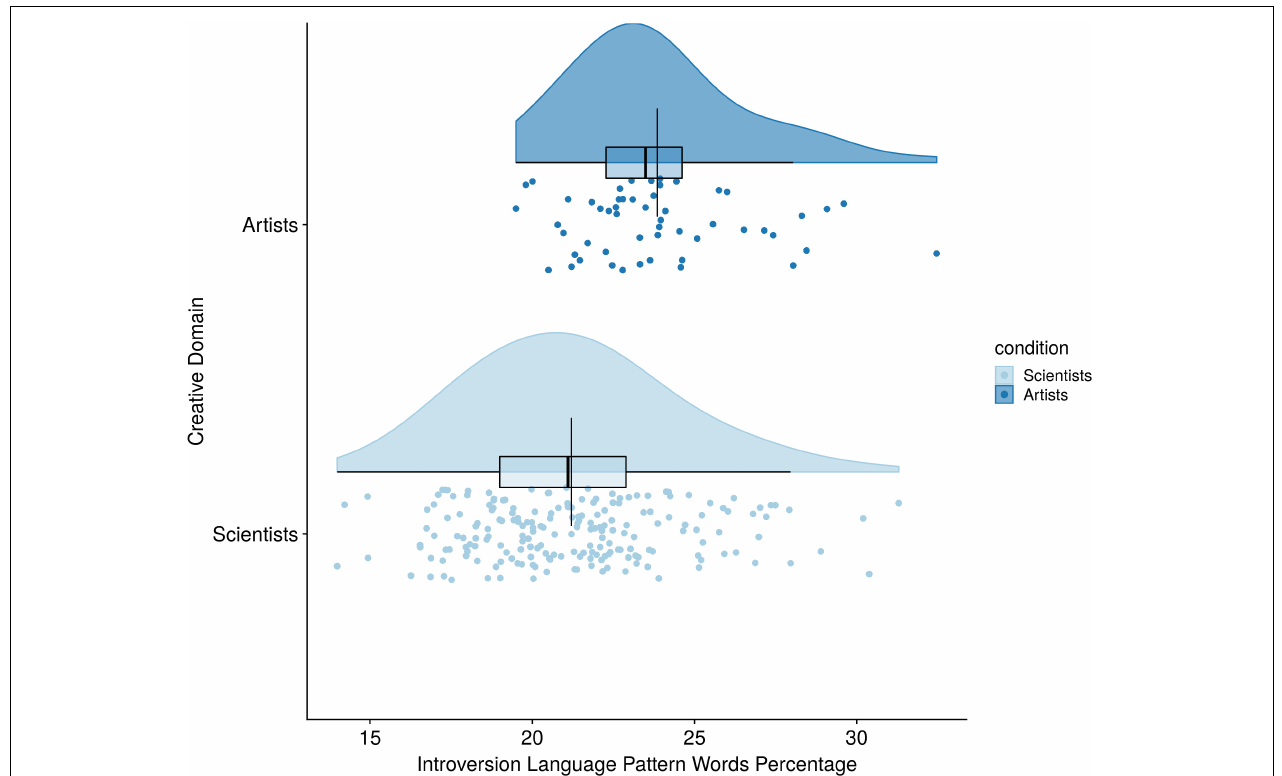
FIGURE 5 | Creative domain differences on introversion language pattern